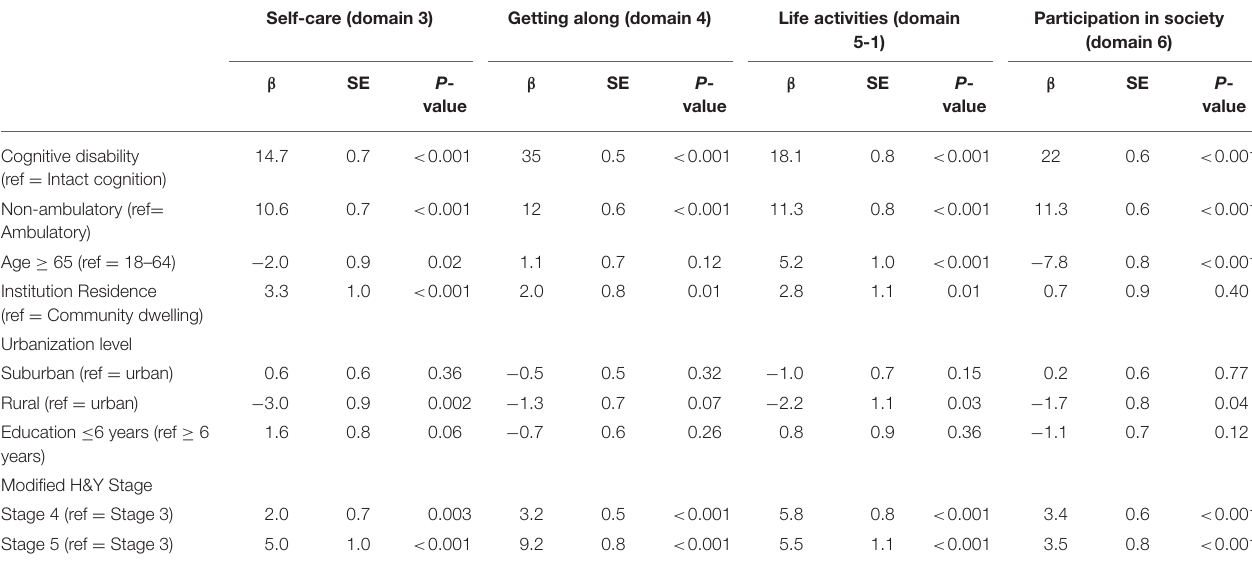
TABLE 3 | Non-parametric regression comparing the effects of cognition and ambulation on WHODAS domains